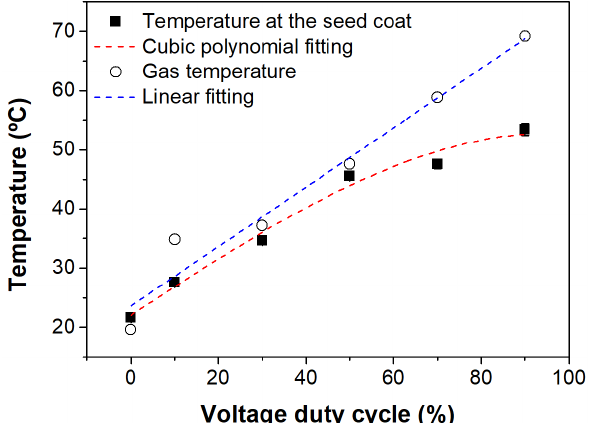
Figure 6. Comparison of the temperature measured inside of the empty reactor (center bottom of the Petri dish) after 3 min and the temperature obtained on the seed surface after treatments for 3 min using different duty cycle values.